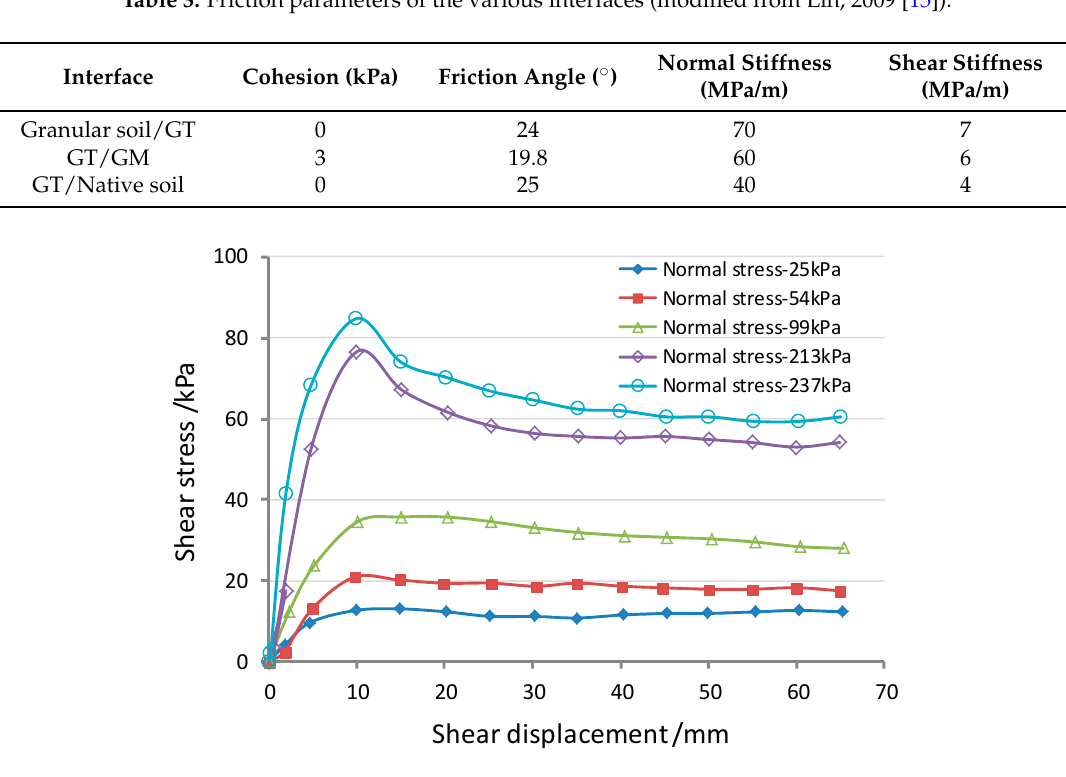
Figure 9. Geotextile-geomembrane friction tests (reproduced from Lin, 2009 [15]).